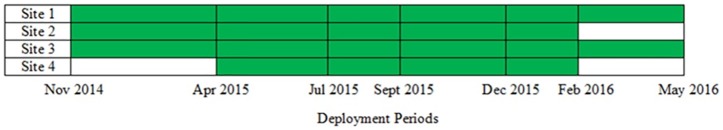
The C-POD deployment periods.Green indicates a complete, uninterrupted dataset and a blank space indicates there were no data during the corresponding deployment period, either due to instrument loss or malfunction.